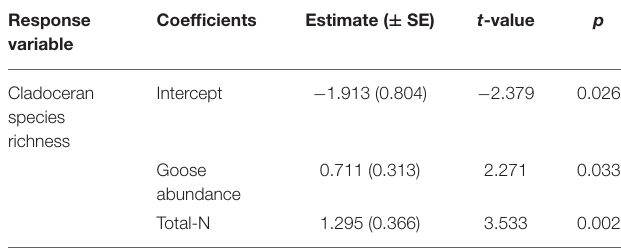
TABLE 1 | Parameter estimates for linear regression models relating cladoceran species richness to the goose abundance (judged from droppings), total-N and total-P [all transformed, log 10 (X +